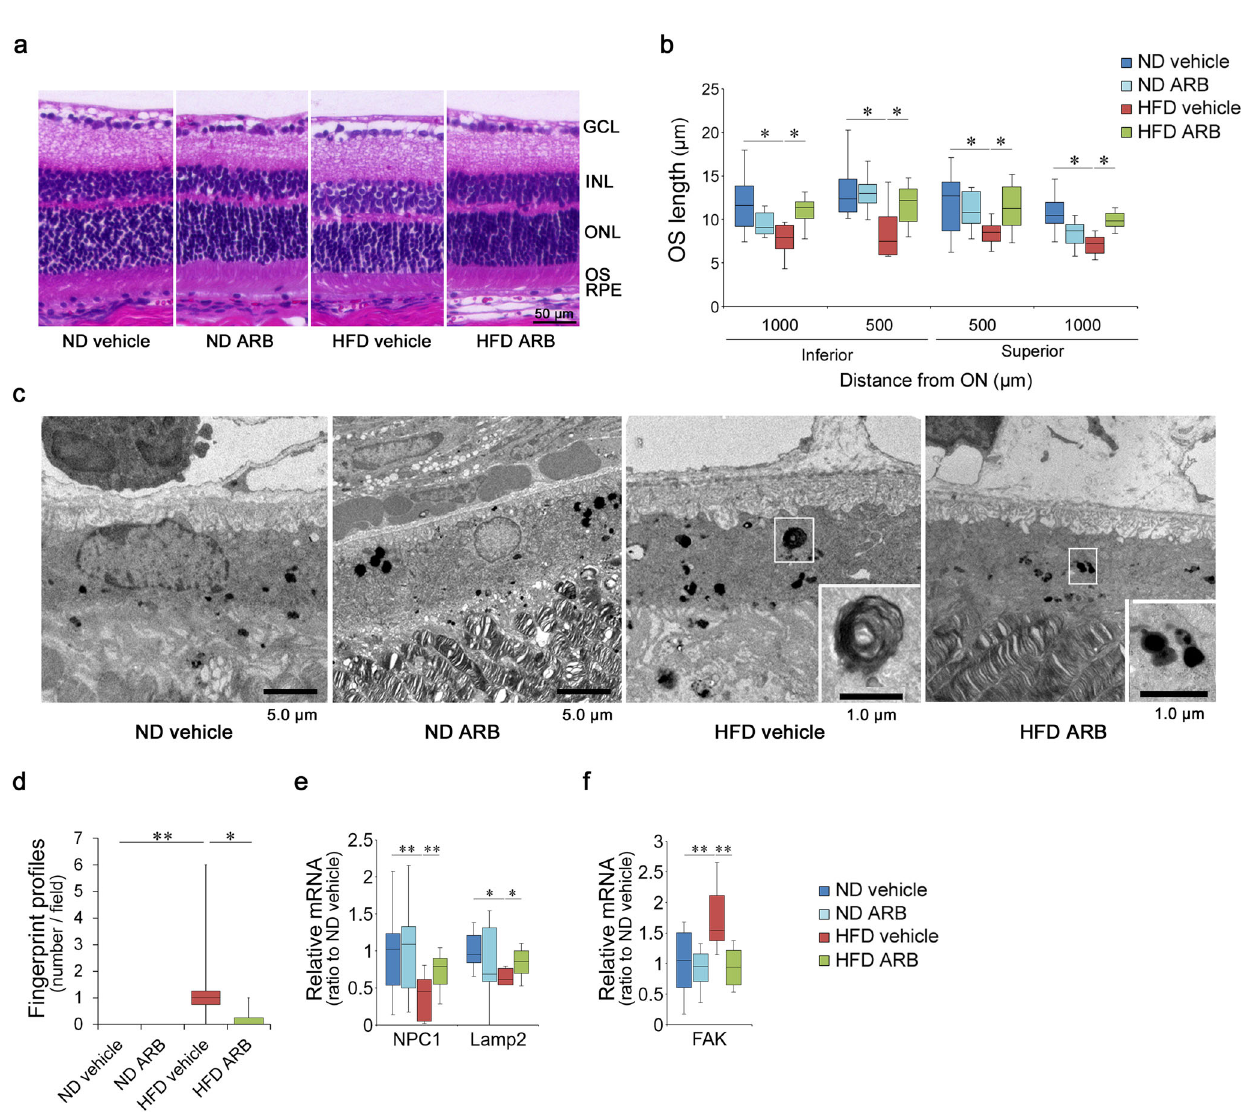
Fig. 2 Retinal histological changes due to HFD were reversed by AT1R blockade. a HE staining of the retina at 1 month. b OS length was reduced by the HFD; however, it was recovered with AT1R blockade by ARB. c , d Electron microscopy (EM) of the RPE. Abnormal structures known as fi ngerprint pro fi les (inset in HFD vehicle sample; magni fi ed image) generated by lysosomal de fi ciency appeared in the RPE of HFD mice; however, these pro fi les were substantially reduced after the AT1R blockade. Note that the fi ngerprint pro fi les differed from the homogenous pigment found in all mice (inset in HFD ARB sample; magni fi ed image). e , f mRNA levels in the RPE – choroid complex. Lysosome markers, NPC1, and LAMP2 ( e ), were downregulated, and an autophagy marker, FAK ( f ), was upregulated in HFD mice, all of which were rescued by ARB. ND normal diet, HFD high-fat diet, AT1R angiotensin II type 1 receptor, ARB AT1R blocker, OS outer segment, RPE, retinal pigment epithelium. Respective numbers for ND mice treated with control, ND mice treated with ARB, HFD mice treated with control, and HFD mice treated with ARB were ( b ) n = 10 for each group. d n = 12 for each group; e 14, 14, 9, 9; f 14, 14, 8, 8. The samples were all biologically independent. Data are expressed as means± standard deviation; b * P < 0.05 for comparison between ND and HFD both treated with vehicle; † P < 0.05 for comparison between HFD treated with vehicle and HFD treated with ARB; d – f * P < 0.05, ** P < 0.01. Scale bar, 2.0 μ m ( a ), 1.0 or 5.0 μ m ( b , c